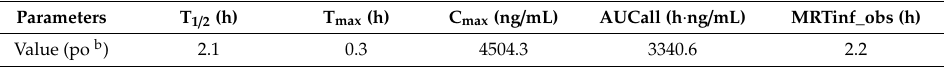
Table 1. Pharmacokinetics Parameters of DFX117 after po administration a